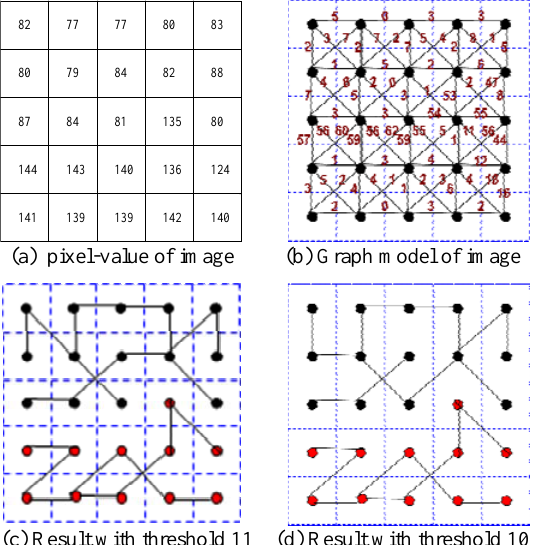
Fig.1 Image Segmentation based on minimum spanning tree of graph